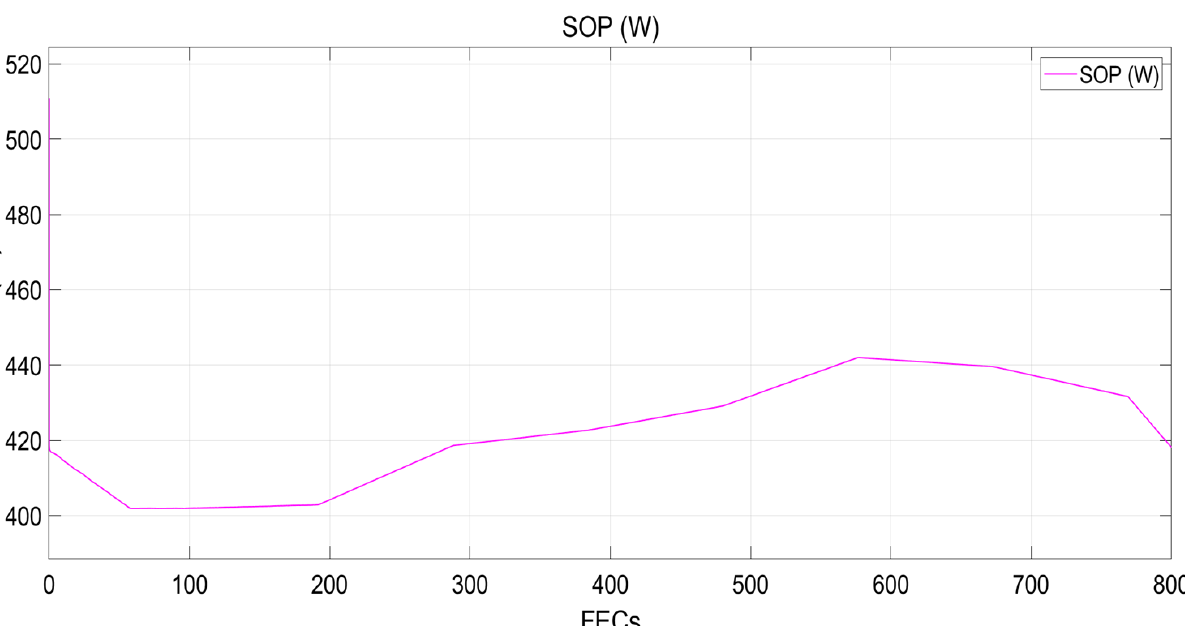
Figure 12. Internal resistance versus SoC relationship with 3D surface fitting.